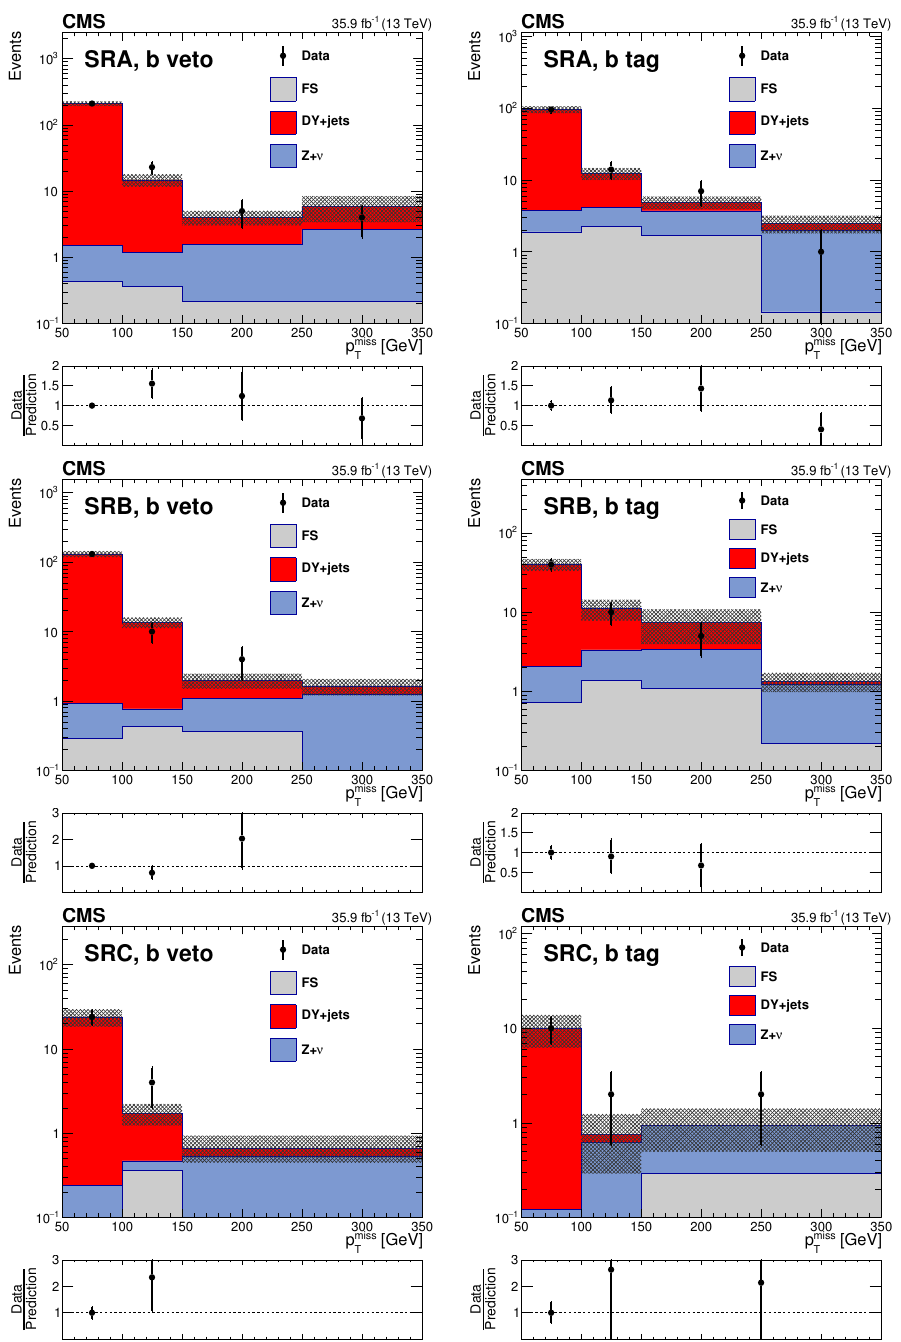
Figure 3 . The p miss distribution is shown for data compared to the background prediction in the T on-Z strong-production SRs with no b-tagged jets (left) and at least 1 b-tagged jet (right). The rows show SRA (upper), SRB (middle), and SRC (lower). The lower panel of each plot shows the ratio of observed data to the predicted value in each bin. The hashed band in the upper panels shows the total uncertainty in the background prediction, including statistical and systematic components. The p miss template prediction for each SR is normalized to the (cid:12)rst bin of each distribution, and T therefore the prediction agrees with the data by construction.